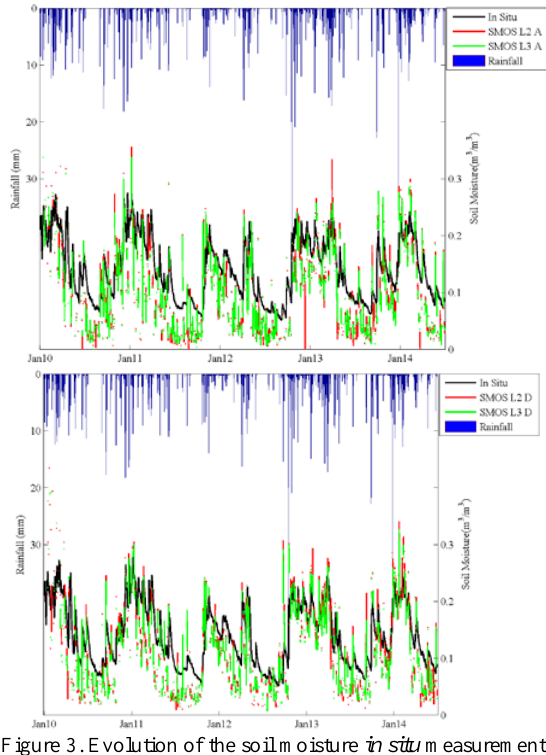
Figure 3. Evolution of the soil moisture in situ measurements (average of stations) and SMOS products (average of DGGs/Pixels), along with rainfall, during the study period (January 2010-June 2014) for the REMEDHUS network. Top, ascending orbit, bottom, descending